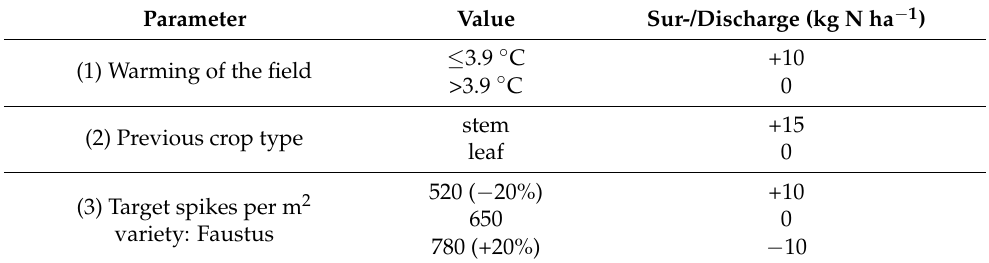
Table 2. Fuzzy sets of parameters in the decision tree for the 1st rate of N application.